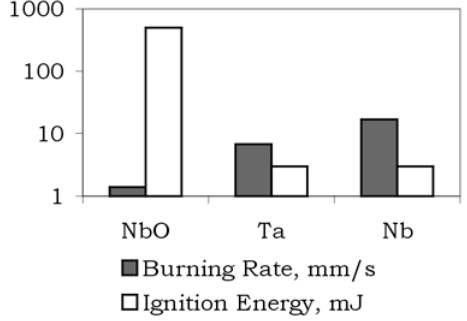
FIGURE 10 Materials